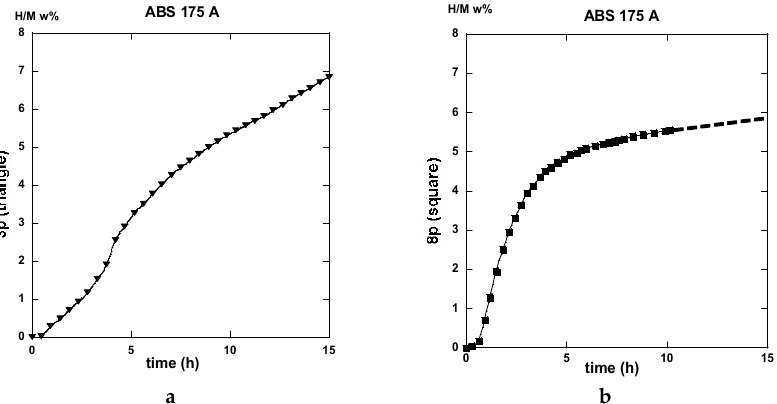
Figure 23. Hydrogen absorption rate (H/M w%) versus time for the samples treated in mode A at 175 ◦ C (black): ( a )—for 3 passes, ( b )—for 8 passes.